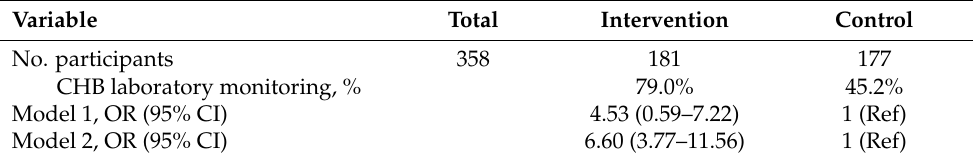
Table 3. Odds Ratio of CHB Laboratory Monitoring at 12-Month Follow-Up of the Intervention Group Against the Control Group, Results from Descriptive Analysis and Generalized Linear Mixed-Effect